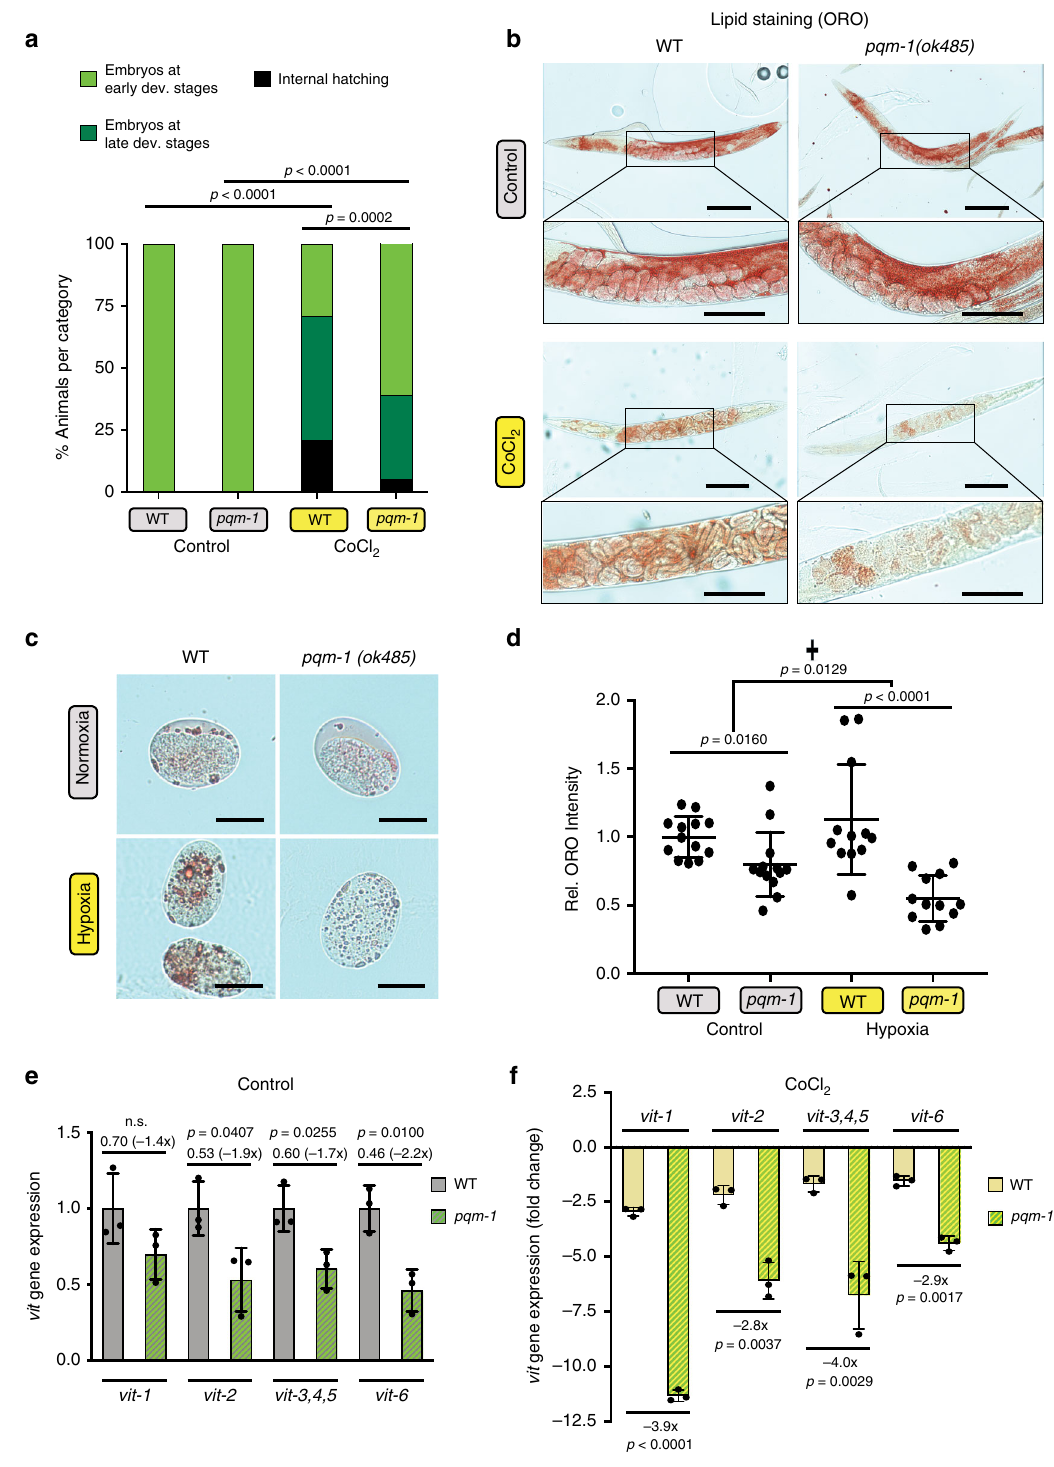
embryos in the uterus were found largely at earlier developmental stages, and the mutants displayed less internal hatching compared to wild-type hypoxic hermaphrodites (Fig. 5a, b). To examine the lipid levels in embryos, we quanti fi ed ORO staining of eggs in hermaphrodites challenged with the real hypoxia and the hypoxia mimetic (Fig. 5c, d and Supplementary Fig. 5a, b). Eggs dissected out of pqm-1 mutants contained signi fi cantly less fat than embryos of wild-type animals, both in control conditions and when exposed to CoCl 2